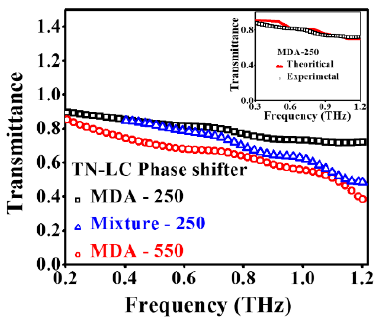
Figure 8. THz transmittance of three types of TN-LC phase shifters at 0 V RMS . The experimental data (symbol) are verified by theoretical calculation (solid line), as shown in the inset.